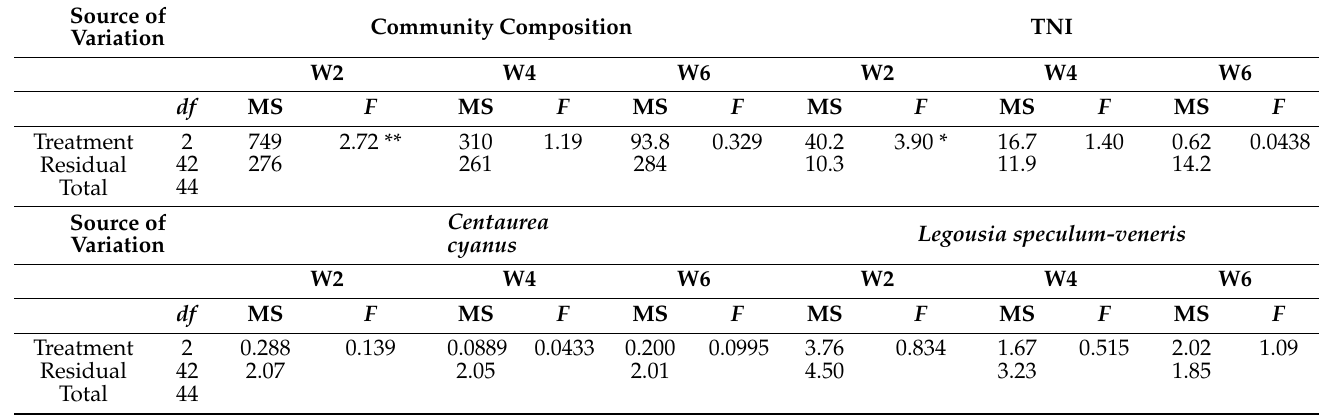
Figure 3. Boxplots showing the total number of individuals per pot per treatment (C = 0% wood distillate; WD1 = 0.2% wood distillate; WD2 = 0.5% wood distillate) at week 2 (W2), week 4 (W4), and week 6 (W6). Different letters indicate statistically significant differences ( α = 0.05). Table 1. Results of the PERMANOVA analyses on community composition with the number of individuals per species as an abundance measure, on the total number of individuals per pot (TNI), and on the total number of individuals of single species per pot at week 2 (W2), week 4 (W4), and week 6